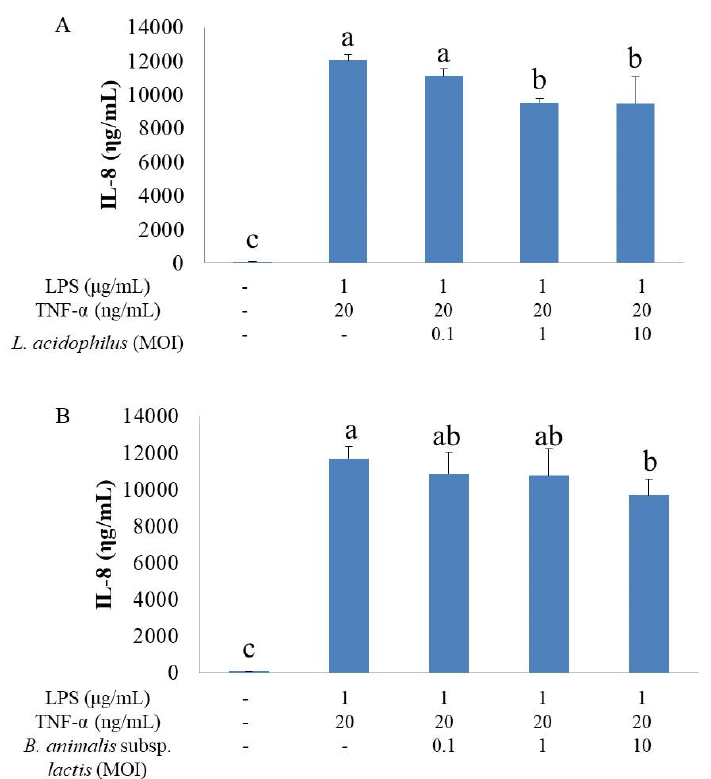
Figure 1. Effects of different doses of single probiotics on IL-8 secretion in inflammatory HT-29 cells. All values except for control are mean ± SD (n = 3). Bars with the same letter are not significantly different from one another determined by Duncan’s multiple range test, p < 0.05. ( A ) The inhibitory effect of L. acidophilus on IL-8 secretion; ( B ) the inhibitory effect of B. animalis subsp. lactis on IL-8 secretion.